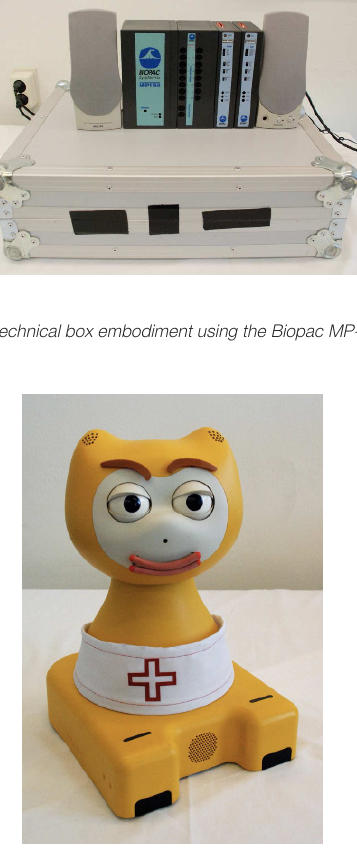
Figure 3. The health iCat